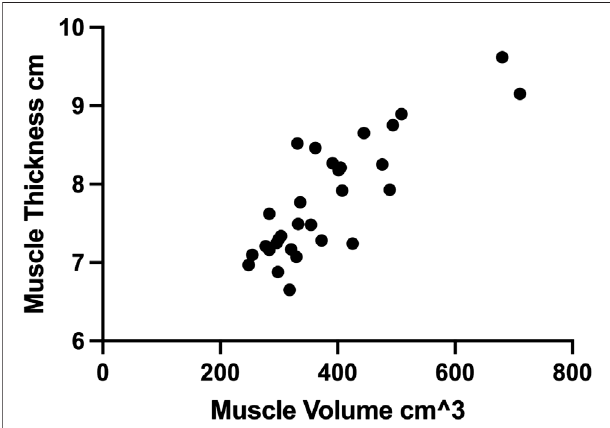
FIGURE6 | The correlation between total muscle thickness of each limb measured by ultrasound and the corresponding muscle volume measured by